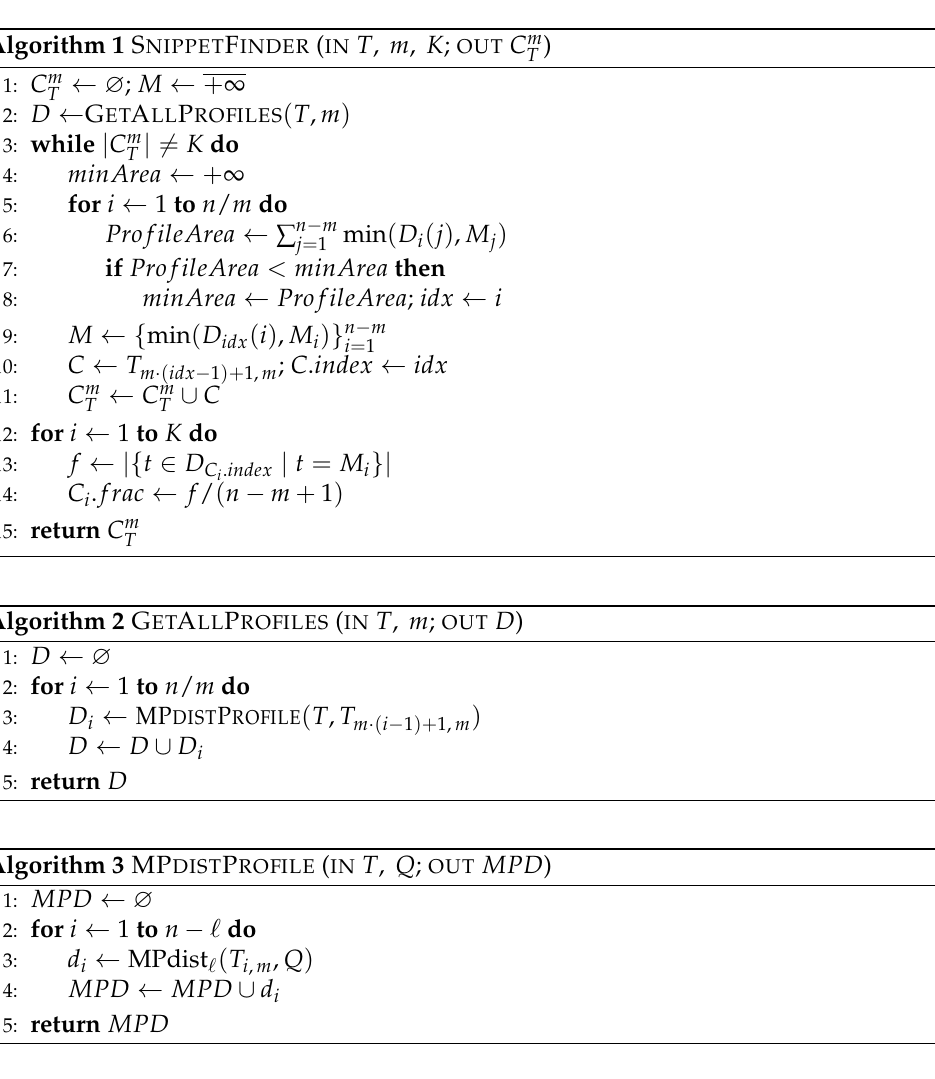
Algorithm 1 S NIPPET F INDER ( IN T , m , K ; OUT C m